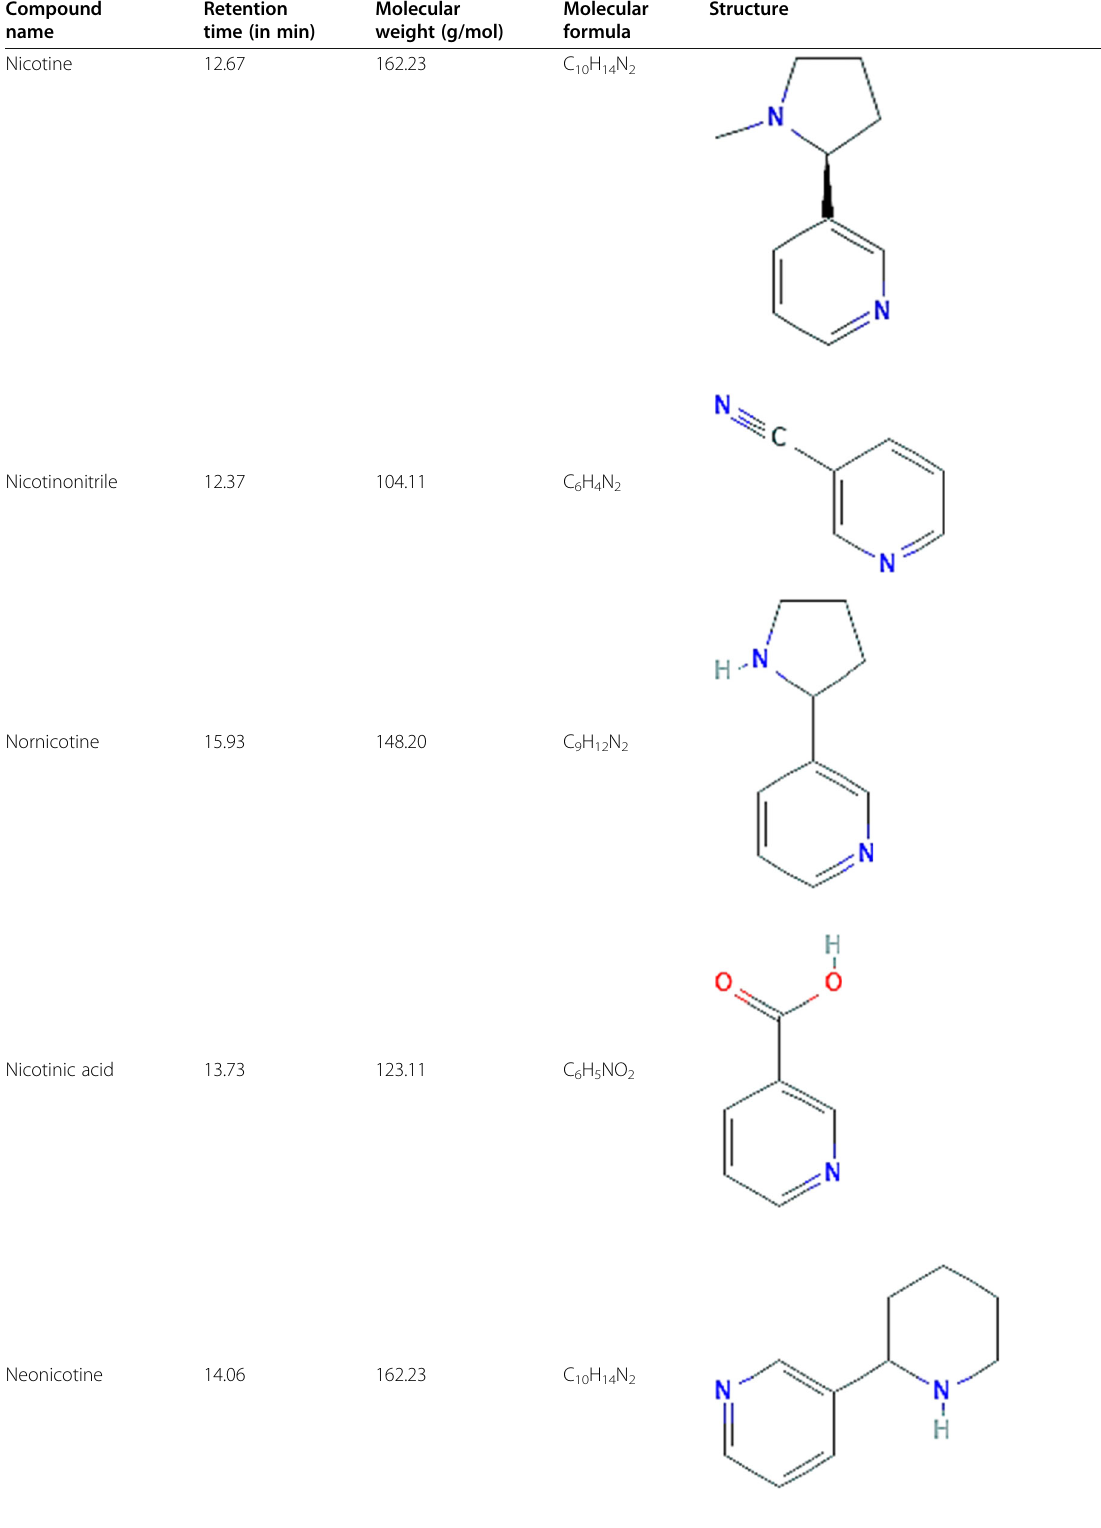
Table 2 Phytochemical compounds in the chloroform and acetone leaf extract of Nicotiana